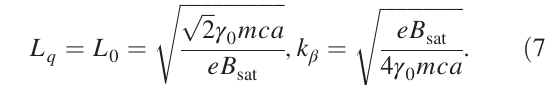
5 × 10 18 V = ð C m 2 Þ . Note that Eq. (3) is an approximate z [note γ ð 1 − α z Þ describes the tail particle energy]. 2 0 2